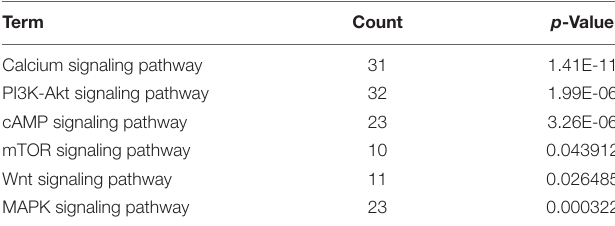
TABLE 2 | The significantly enriched pathways related to muscle fiber type transformation. Term Count p